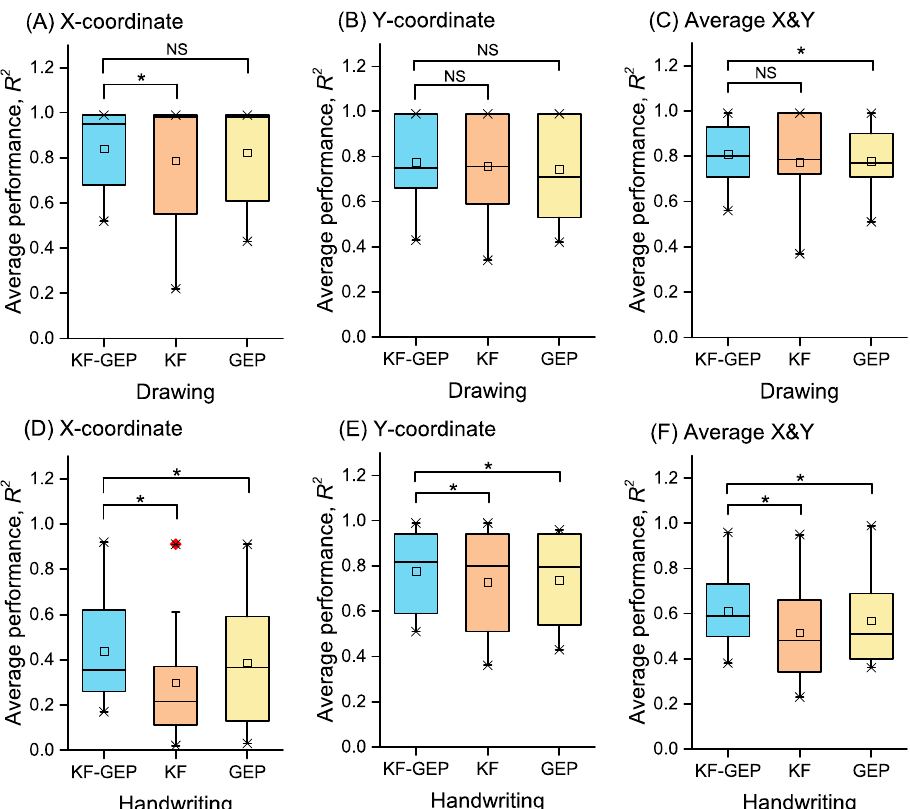
Figure 18. The averages of R 2 s in between-group reconstruction achieved by three methods. Statistical difference between the KF-GEP and KF and between the KF-GEP and GEP was measured by paired sample Wilcoxon signed-rank test: * the KF-GEP’s performance do significantly tends to be greater than the KF’s and GEP’s at the 0.05 level.